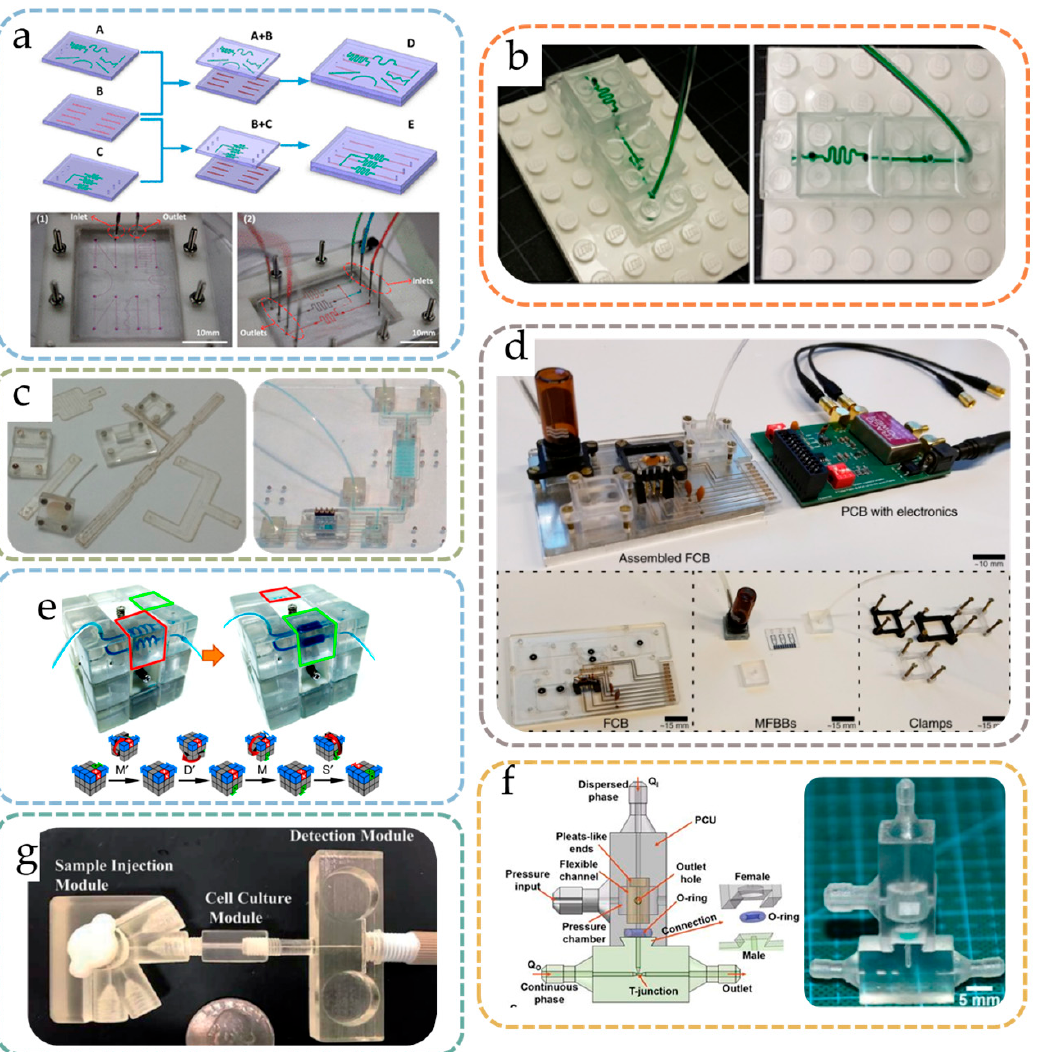
Figure 2. Different forms of modular microfluidic systems: ( a ) multilayered modular system with interchangeable layers by Qiu et al. Reprinted with permission from Ref. [18]. 2017, American Chemistry Society; ( b ) Lego ® -style baseplate positioning of blocks by Vittayarukskul et al. Reprinted with permission from Ref. [25]. 2017, IOP Publishing; ( c ) magnet-enabled interconnection of microfluidics presented by Gomez et al. [31]; ( d ) microfluidic analog of a PCB, a fluidic circuit board with connectable module components, presented by Dekker et al. [37]; ( e ) Rubik’s cube-like coaxial microfluidic systems, where the microfluidic blocks rotate around three shared axes [41]; ( f ) modular assembly of interlocking blocks with shape complementarity, presented by Ji et al. [45]; ( c – f ) reprinted under Creative Commons Licenses; ( g ) threaded fitting of microfluid building blocks by Munshi et al. Reprinted with permission from Ref. [49], Royal Chemistry Society.